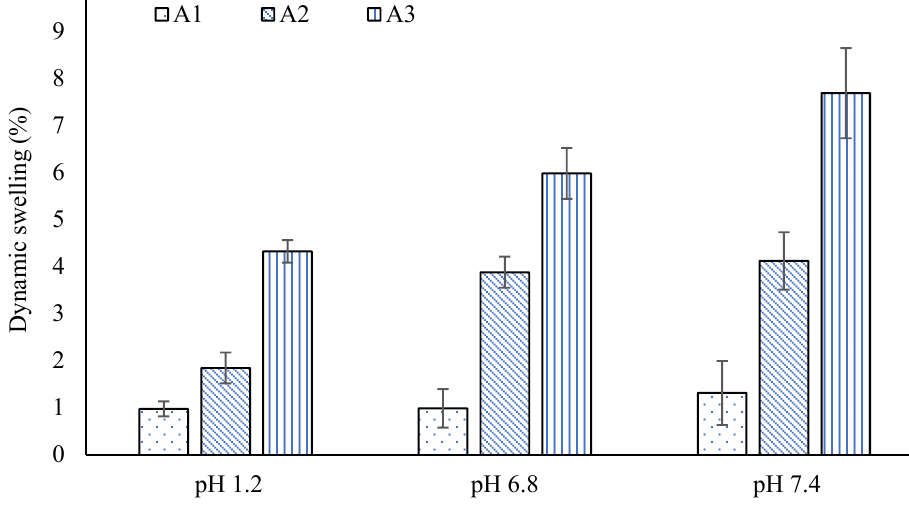
Figure 2. Effect of AM on dynamic swelling of 5-FULH.